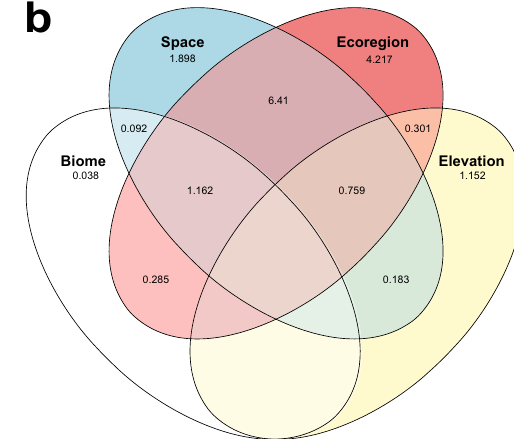
Fig. 4 | Venn diagrams showing the relative contributions (%) of our main predictor variables to explaining the variation in interaction dissimilarity ( β WN ), calculated using deviance partitioning. Overlapping areas represent deviancethatisjointlyexplainedbyoneormorepredictorvariables. a Therelative contributions of ecoregion, biome, spatial and human disturbance (i.e., footprint) distances.In b ,wereplacehumandisturbancedistancewithelevationaldifference;